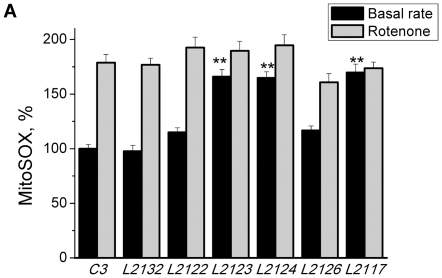
Increase in mitochondrial ROS production in fibroblasts with PINK1 mutations.Fibroblasts with PINK1 mutations displayed a higher basal rate of increase in Mitosox fluorescence, demonstrating a higher basal production of ROS compared to controls. Inhibition of complex I with 5 µM rotenone induced a significant increase in ROS production in control fibroblasts but only a small increase in ROS production in fibroblasts with PINK1 mutation. Histogram demonstrates %age values of rate of Mitosox fluorescence compared to 100% for control (C3) fibroblasts.